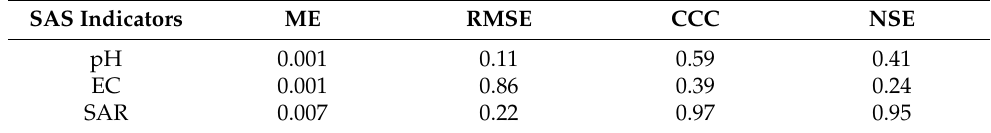
Table 4. The performance of spatial predictions by 10-fold cross-validation.